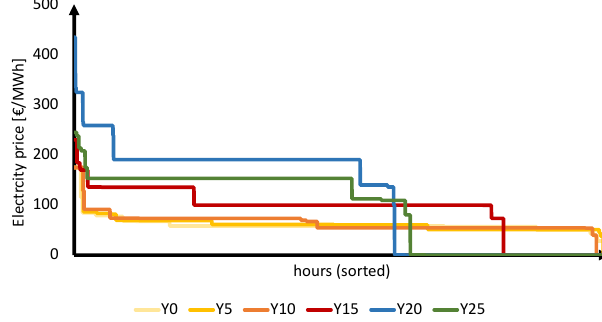
Figure 6. Development of price duration curves over modelling time in iteration 0.